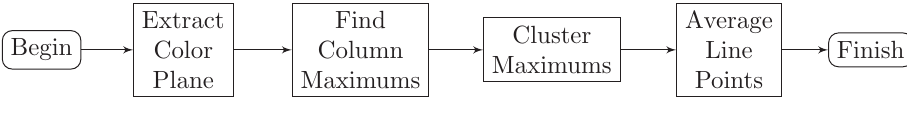
Figure 9. Overview of the line extraction